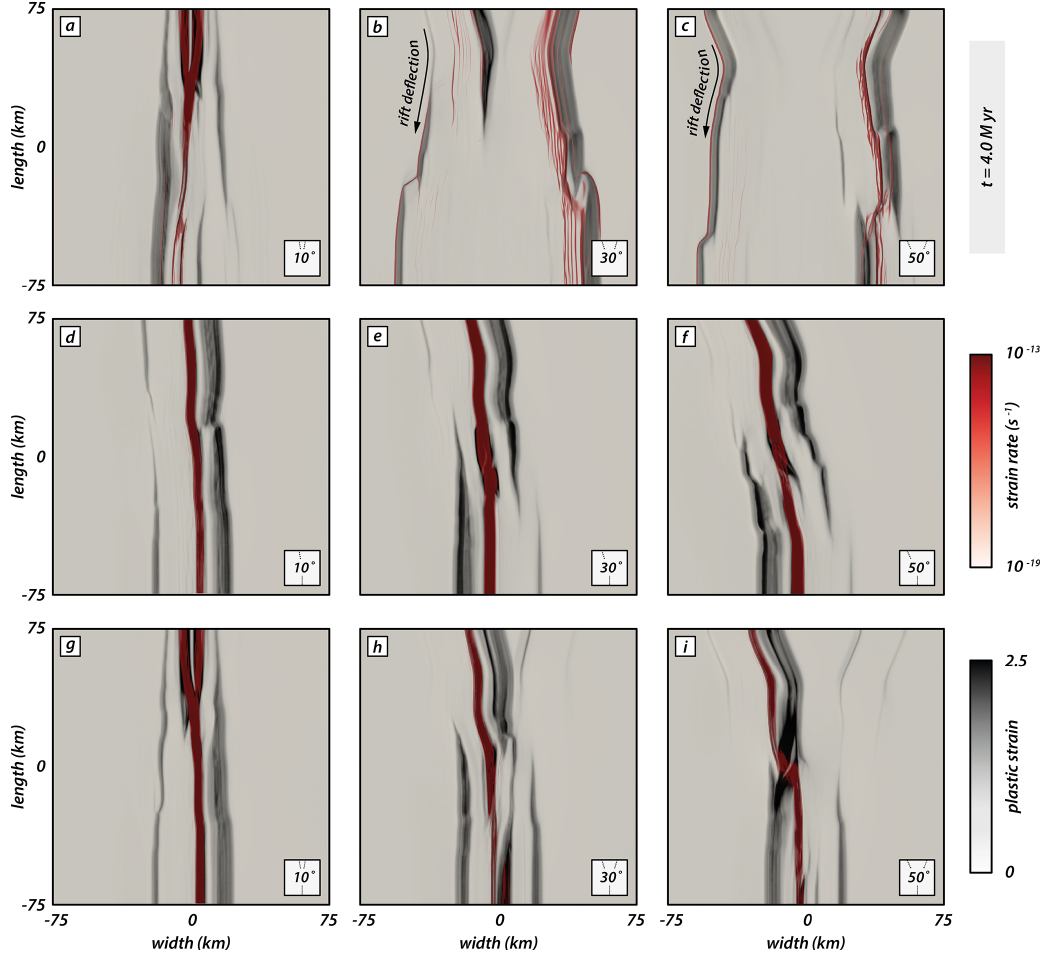
Figure 7. Influence of seed configuration on the final rift geometry after 4 million years. Strain rates (logarithmic) and plastic strain are indi- cated by red and black, respectively. (a–c) The v -seed configuration for intermediate angles of 10, 30, and 50 ◦ . (d–f) The i -seed configuration for intermediate angles of 10, 30, and 50 ◦ . (g–i) The y -seed configuration for intermediate angles of 10, 30, and 50 ◦ (reference